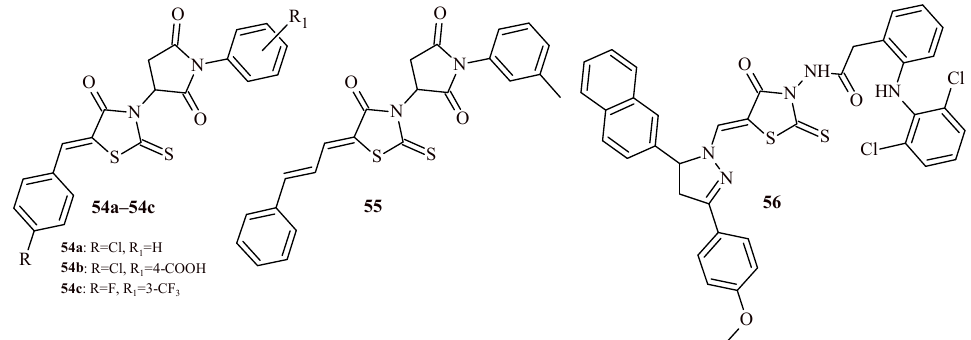
Figure 23. The structures of rhodanine- N -arylsuccinimid and rhodanine-pyrazoline hybrids.